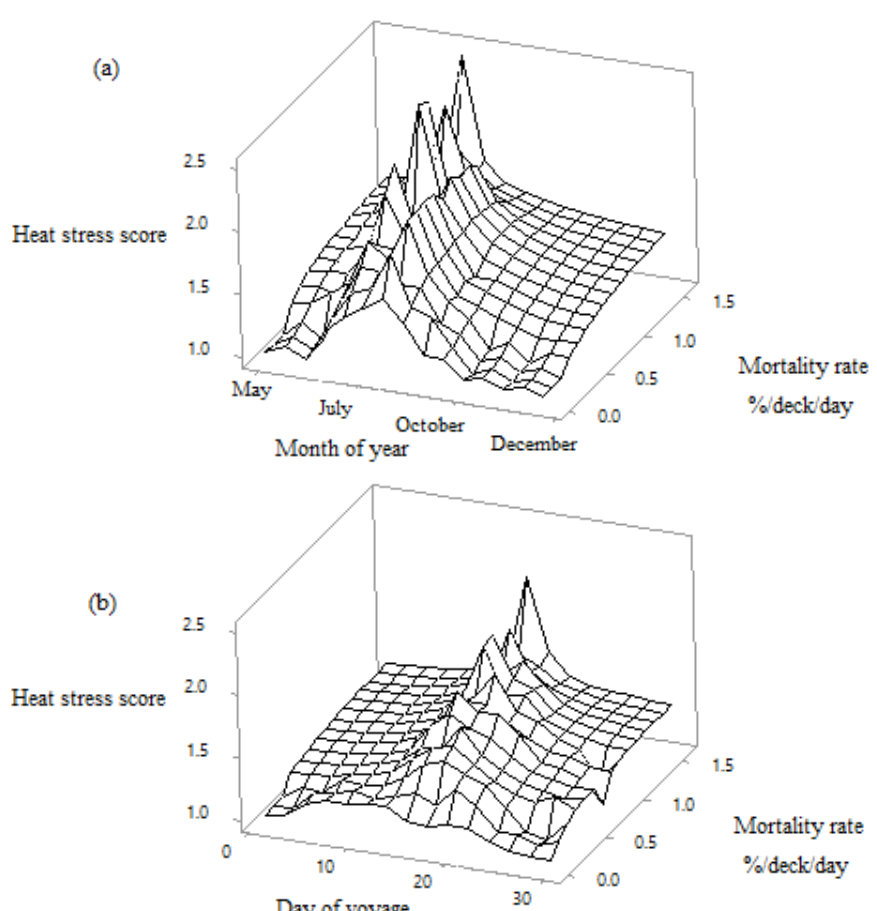
Figure 11. Relationships between heat stress score (1 = normal, 2 = moderate and 3 = severe), mortality and both month ( a ) and day ( b ) of the voyage.